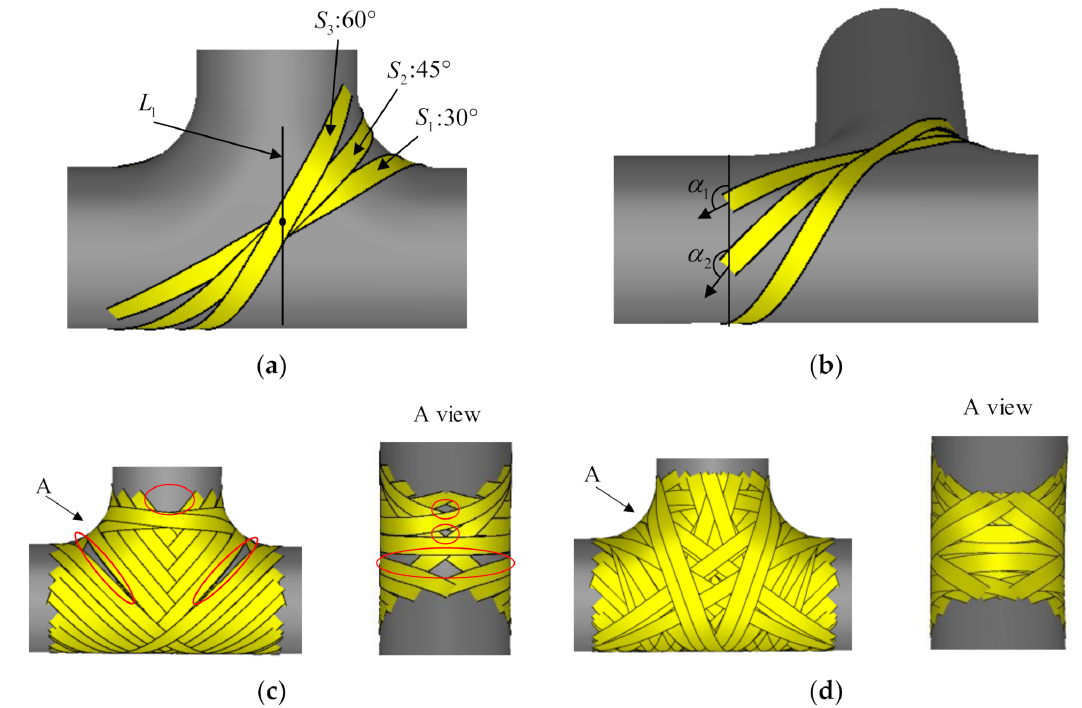
Figure 5. Full cover problems of T-junction: ( a ) Tracks corresponding to different winding angles; ( b ) Winding angle of boundary design point; ( c ) Uncovered area of T-junction; ( d ) Fully covered area of